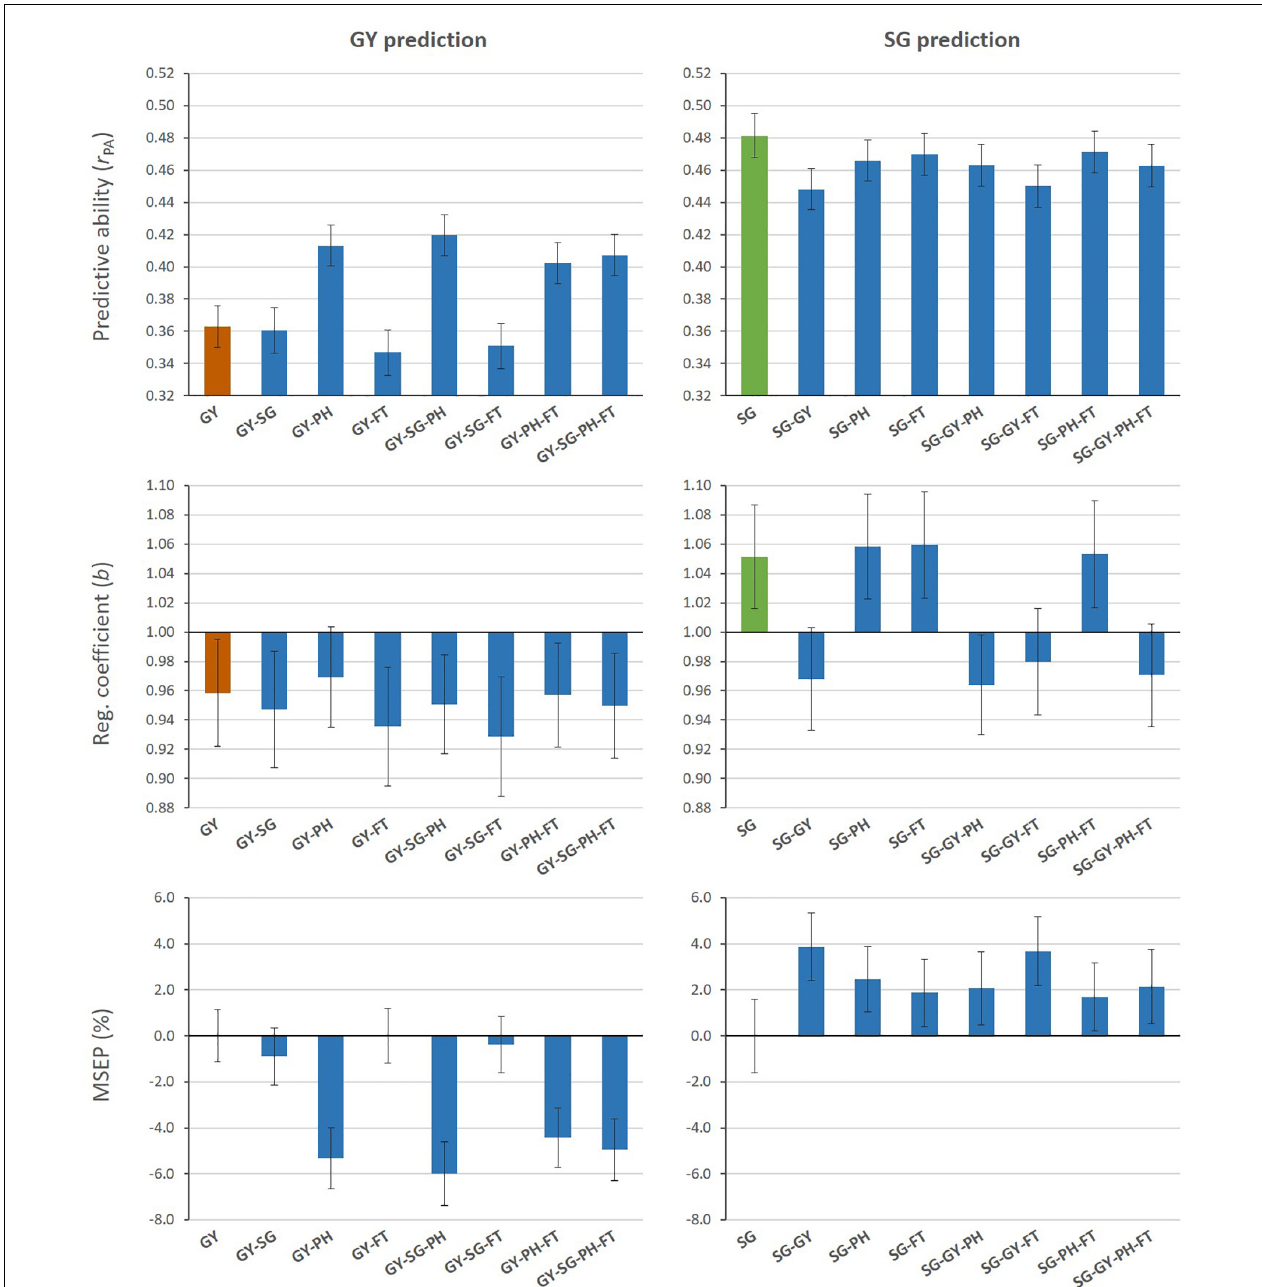
FIGURE 2 | Mean values (and SD of 20 replicates) for predictive ability, regression coefficient, and relative MSEP from single- and multi-trait G-BLUP models using different combinations of grain yield (GY), stay-green (SG), plant height (PH), and flowering time (FT) data in the training lines set for prediction of GY (left) or SG (right).